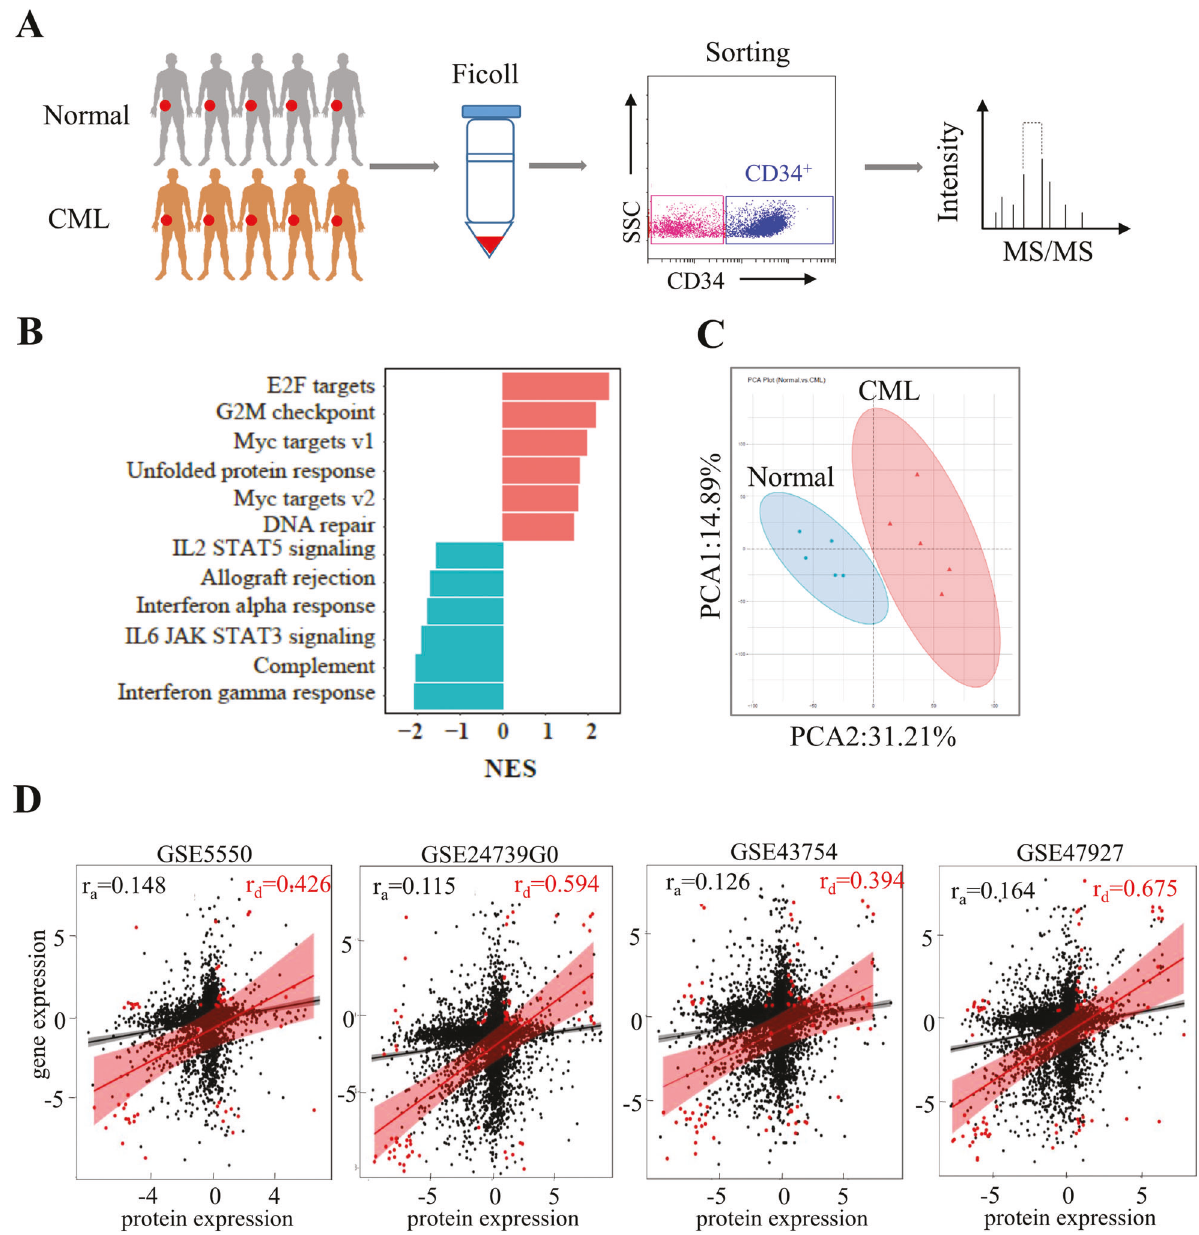
Fig. 1 Metabolic proteome signature of CD34 + leukemia cells. A Diagram of experimental design. B Bar plots of top-ranked HALLMARK pathways that are signi fi cantly altered in CD34 + leukemia samples compared with the normal counterpart. NES: Normalized Enrichment Score. C The 2D plot of PCA between the CD34 + CML samples and normal samples. The differentially expressed proteins were used to carry out the analysis under the threshold of FC (fold change) >2 and P < 0.01. PCA1 and PCA2 denote the fi rst and second principal component, respectively. D Correlation coef fi cient was calculated between the CD34 + cells protein log2 ratios ( n = 5 patient samples, n = 5 normal samples) and transcript logFC in the four datasets (GSE24739, GSE43754, GSE47927, and GSE5550) using Pearson method. Filled black circles indicate all proteins/genes; fi lled red circles indicate regulated proteins/genes (FC > 2, P < 0.001). r a all proteins/genes correlation, r d deregulated proteins/genes including Complex I of the respiratory chain and glycerol-3- measured the OCR and ECAR of CML CD34 + cells derived from phosphate dehydrogenase (GPD2), as well as cytoplasm target three individuals treated with metformin. Consistent with the AMP-dependent kinase (AMPK) due to modulation of AMP/ATP proteomic results, metformin upregulated both ECAR and OCR of ratio [33 – 38]. Interestingly, top enrichment of cell component 24 h CD34 + CML cells (Fig. 4D, E). These data suggested that the impact post metformin treatment is endoplasmic reticulum (ER) proteins of metformin on CD34 + CML cells is not through the well-known with 17 of which have been proposed to modulate by metformin mechanism on mitochondria metabolism. (Fig. 4F). To validate the activation of ER stress, we treated CML The mechanisms underlying the action of metformin are CD34 + and normal progenitors with metformin and detected complicated and still not fully understood. At the molecular level, metformin has been shown to act toward mitochondrial targets markers of ER stress signaling. We observed a signi fi cant increase